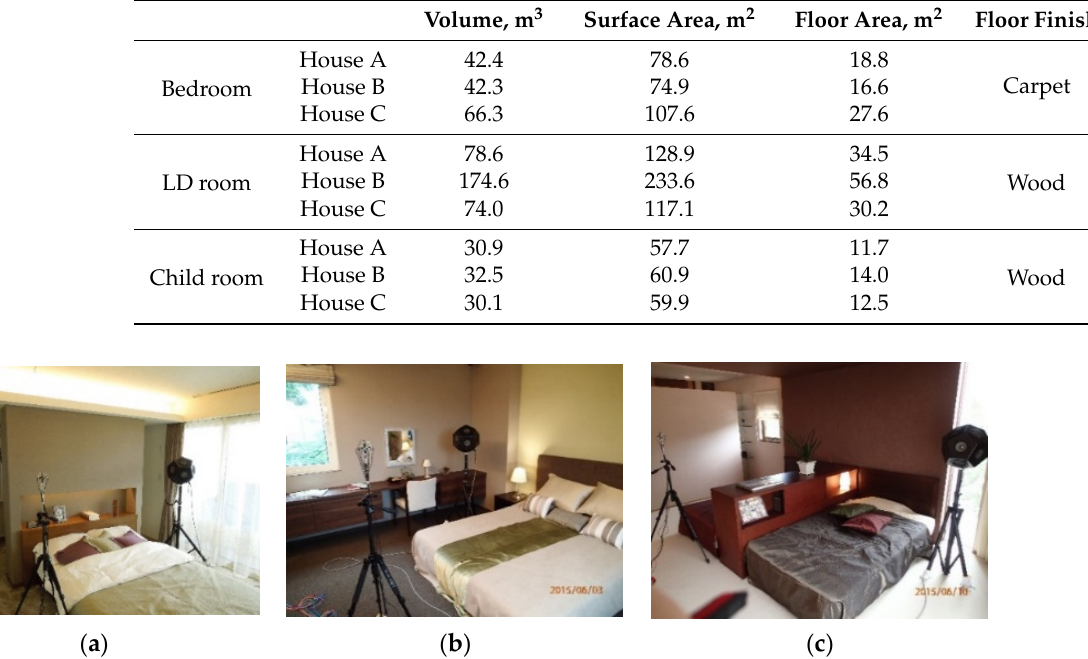
( c ) Figure 10. Measurement of impulse responses in the three child rooms: houses ( a ) A, ( b ) B, and ( c ) C.